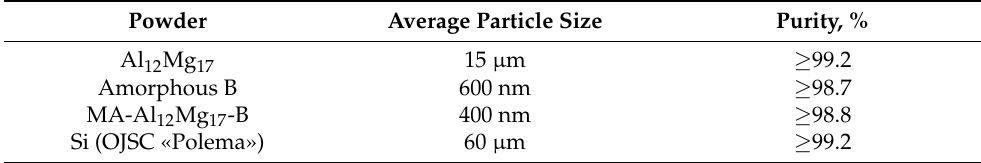
Table 1. Characteristics of the raw powders.